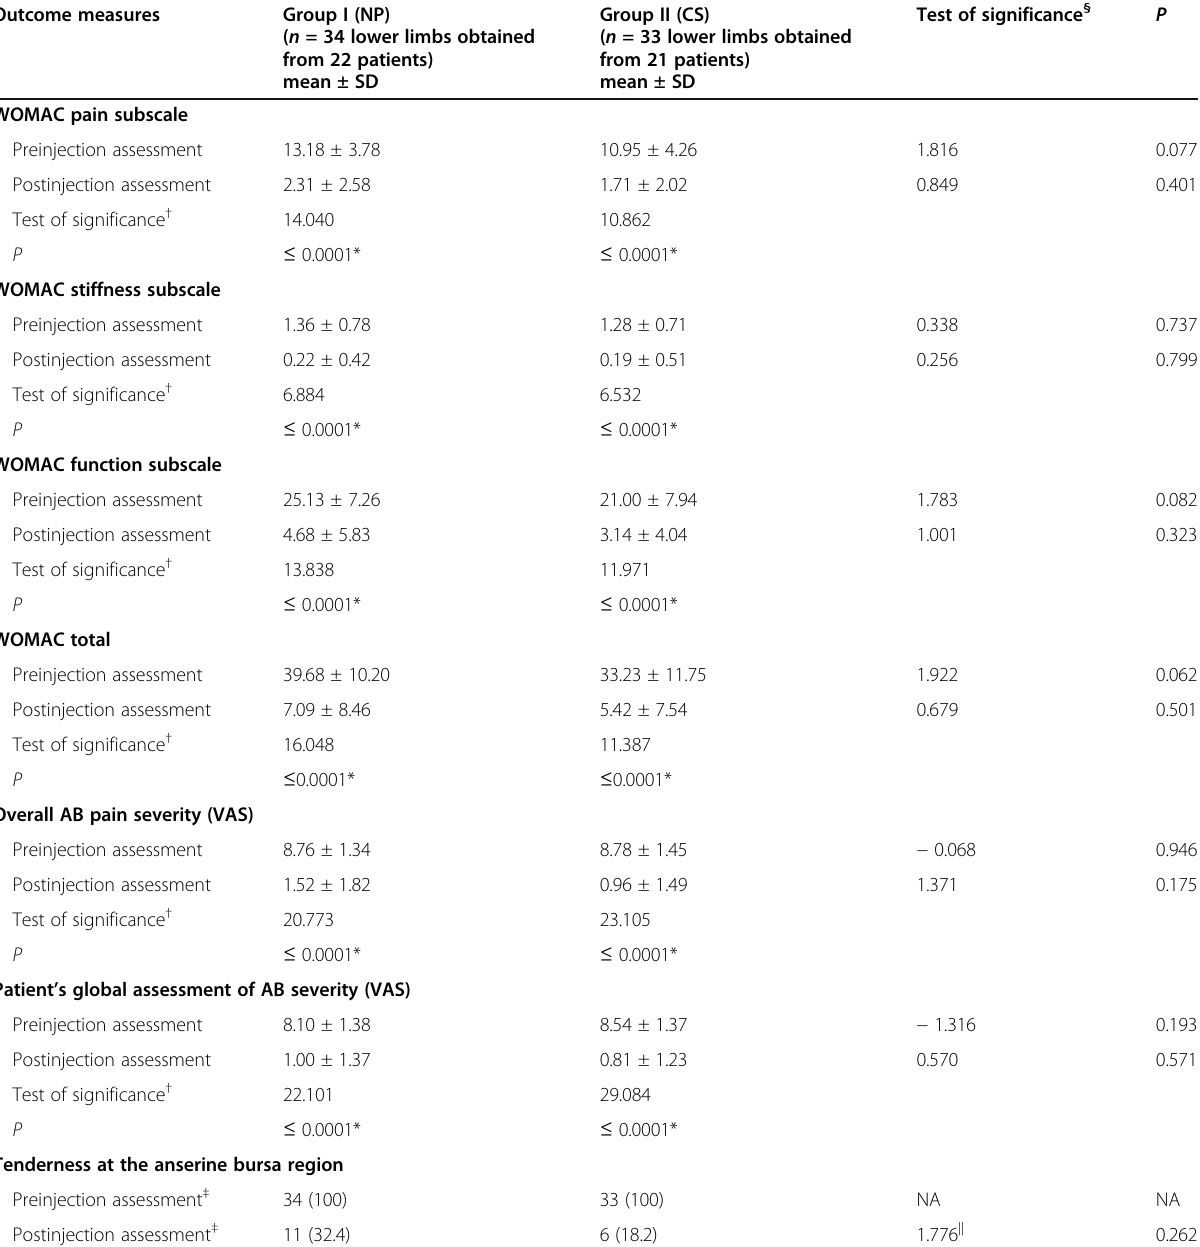
Table 2 Comparison between the preinjection and postinjection assessments regarding outcome measures among the two treatment